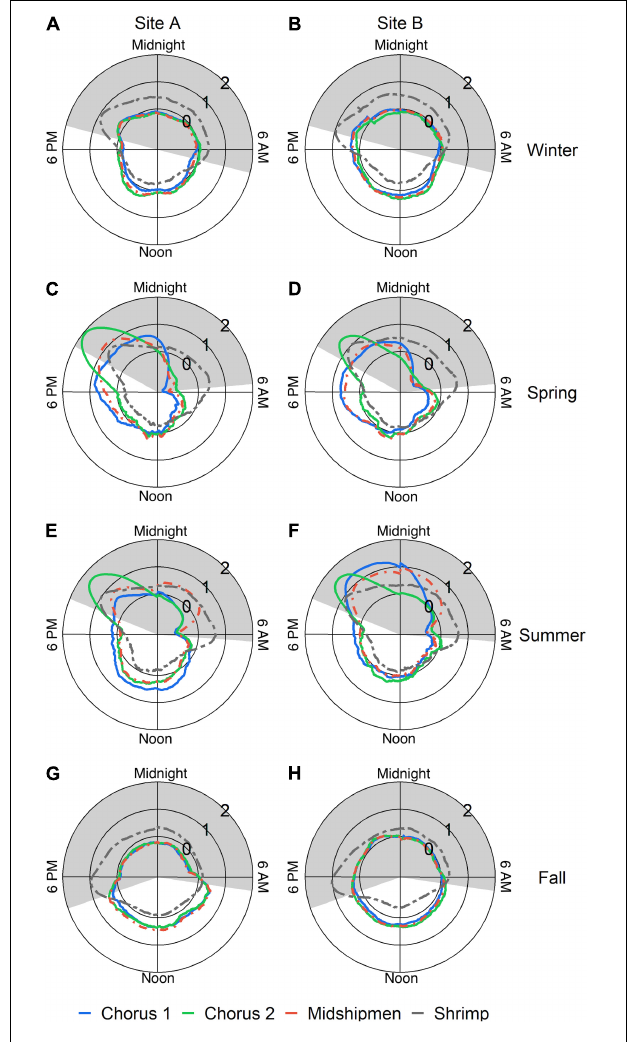
FIGURE 4 | Canonical time series of the four frequency bands of interest created from the LTSAs during different seasons (November 2016 – August 2017). (A,C,E,G) represent Site A, and (B,D,F,H) represent Site B. Each frequency band of interest is represented within each panel by color (blue: 60 – 130 Hz chorus, green; 300 – 500 Hz chorus, orange: midshipmen band, and gray: snapping shrimp band). Gray arcs represent nighttime (sunset to sunrise). Radial scale is z-score standardized spectrum levels for each